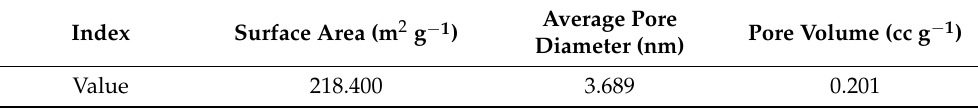
Table 3. The isothermal nitrogen adsorption–desorption report of NZVIs-BC (FS:RS =